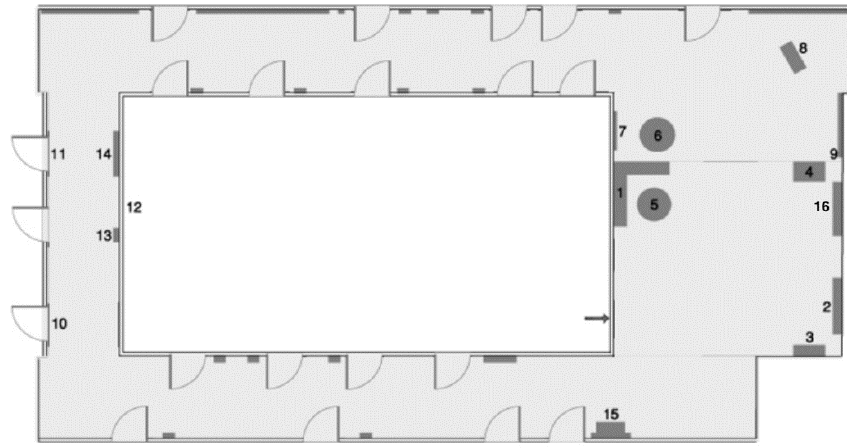
Figure 2. Complex space.